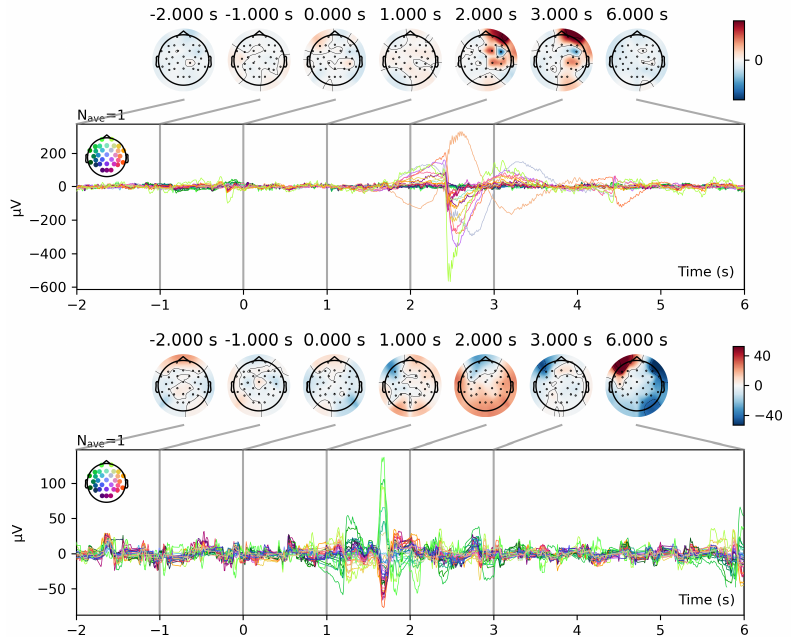
Figure 11. Butterfly plots based on EEG signals (32 channels) with scalp topographies for two participants; at time 0, the event with the label Stroop 2